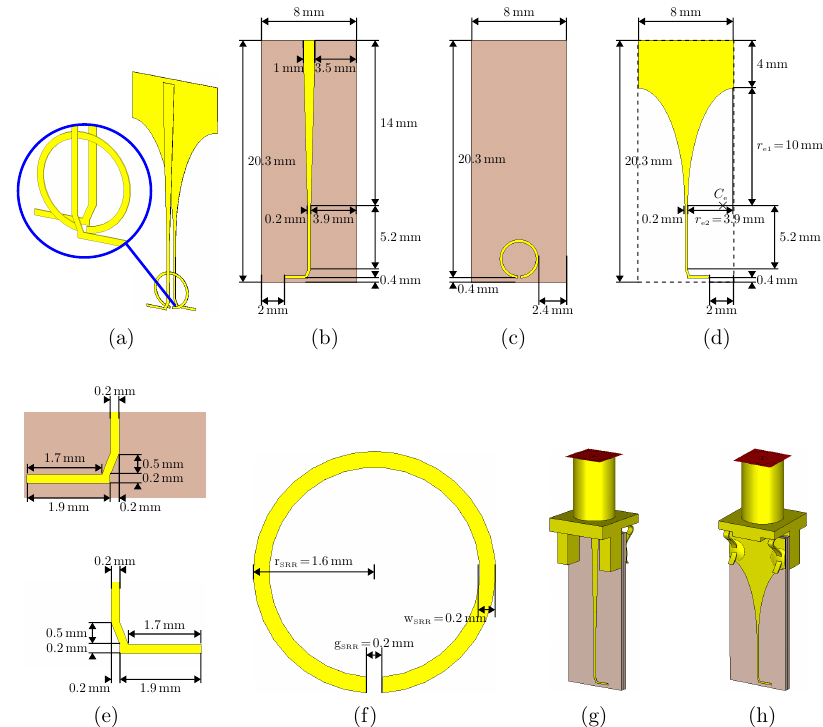
Figure 1. ( a ) Schematic layout of the dipole antenna with split-ring resonator (SRR). The substrates are not shown for the sake of simplicity; ( b ) Feed line and left dipole arm on the top side of the top substrate. The metal layers and Rogers RT/Duroid R (cid:13) 5880 substrates are shown in yellow and brown, respectively; ( c ) SRR on the top side of the bottom substrate as middle layer; ( d ) Right dipole arm on the bottom side of the bottom substrate as bottom layer; ( e ) Physical dimensions of the left and right dipole arms; ( f ) Physical dimensions of the SRR; ( g ) Hybrid antenna with SMA connector (bottom side); ( h ) Hybrid antenna with SMA connector (top